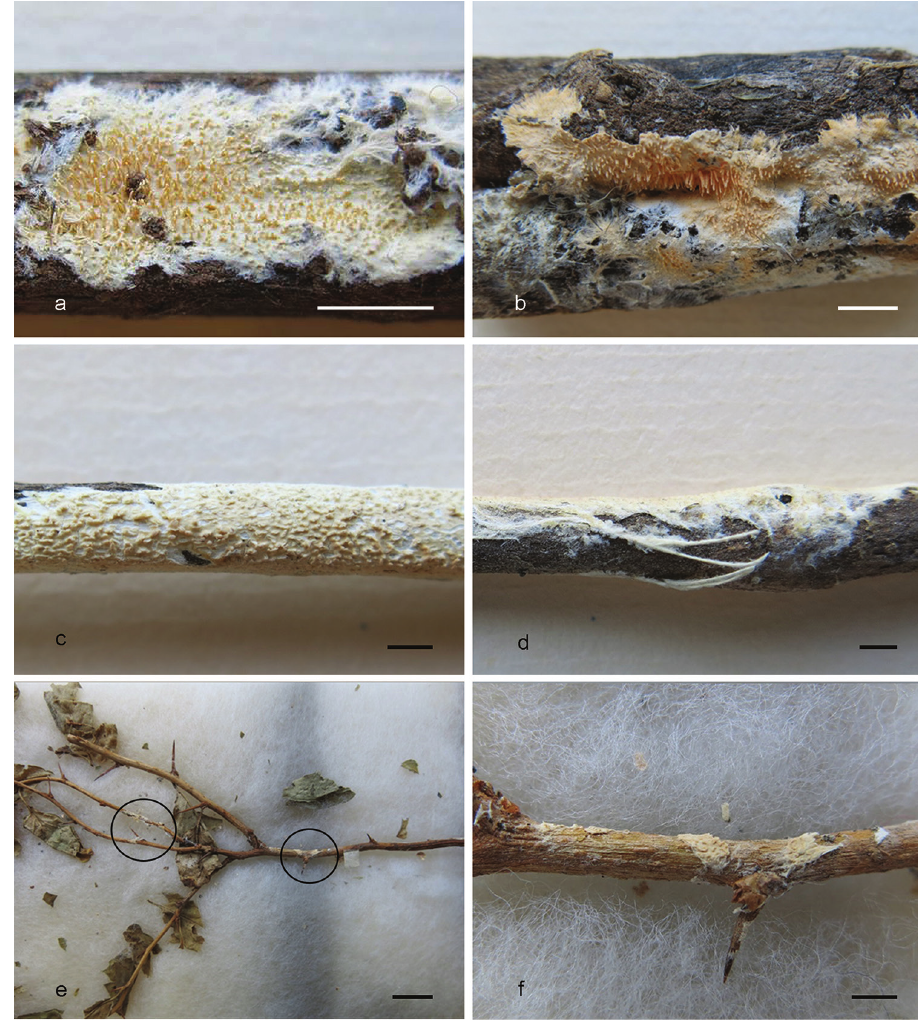
Figure 6. Hydnophlebia gorgonea. a Collection 19111Tell., MA-Fungi 86659, holotype, basidiome, dry specimen b Collection 19133Tell., MA-Fungi 86664, basidiome, dry specimen. Hydnophlebia meloi c , d Collection 19071Tell., MA-Fungi 86654, holotype, basidiome, dry specimen (c), and margin and strands, dry specimen (d). Hydnophlebia omnivora e Collection 5267 C.R. Shear coll., BPI, holotype f Basidiome, dry specimen. Scale bars: a–b = 5 mm; c–d, f = 2 mm; e = 10 mm.